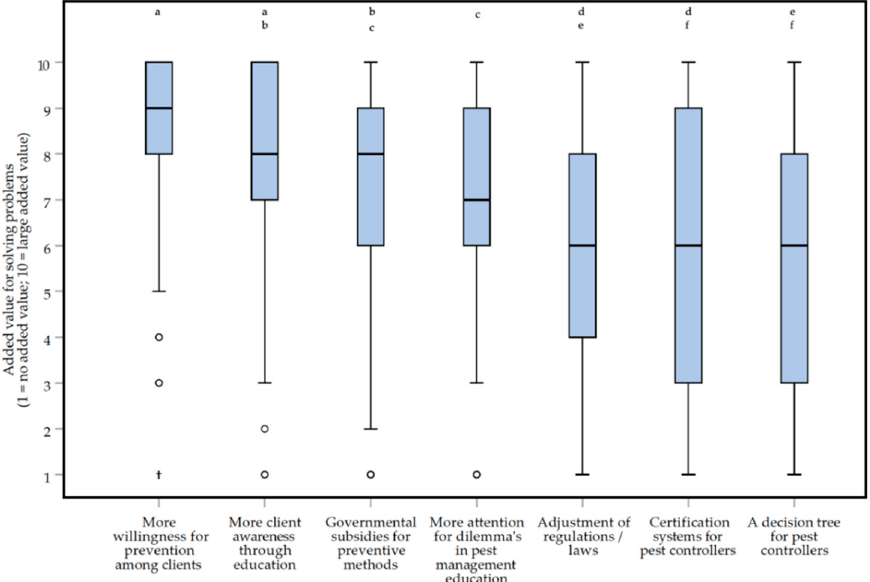
Figure 8. Box plots presenting the added value of different possible solutions for problems in practice on a 1 (no added value) to 10 (large added value) rating scale. Solutions were scored by 129 Dutch pest controllers, participating in an online survey about the treatment of rats ( Rattus rattus and Rattus norvegicus ) and mice ( Mus musculus ). Differences between the two solutions that are not statistically significant are indicated with letters above the bars.